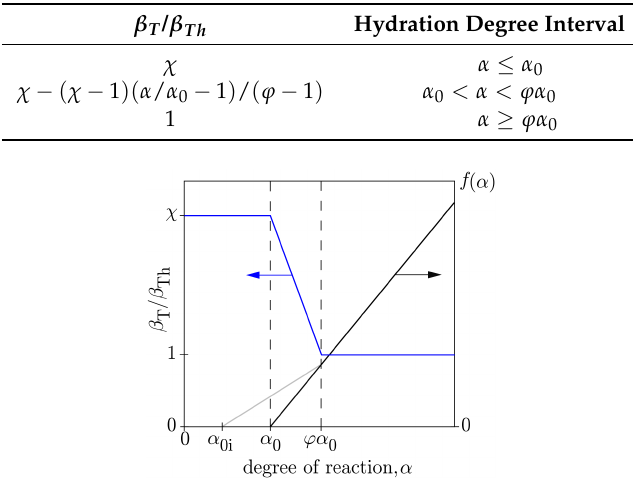
Table 2. Modeling of coefficient of thermal expansion.